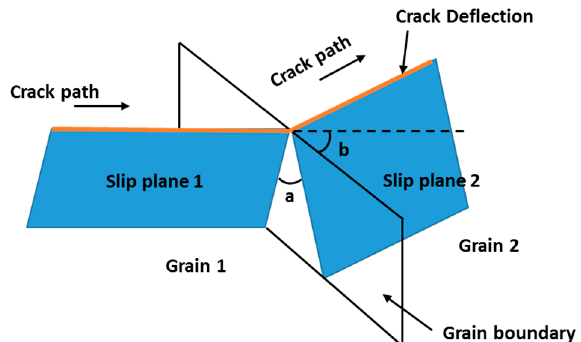
Figure 13. Crack deflection. Metals 2018 , 8 , x FOR PEER REVIEW